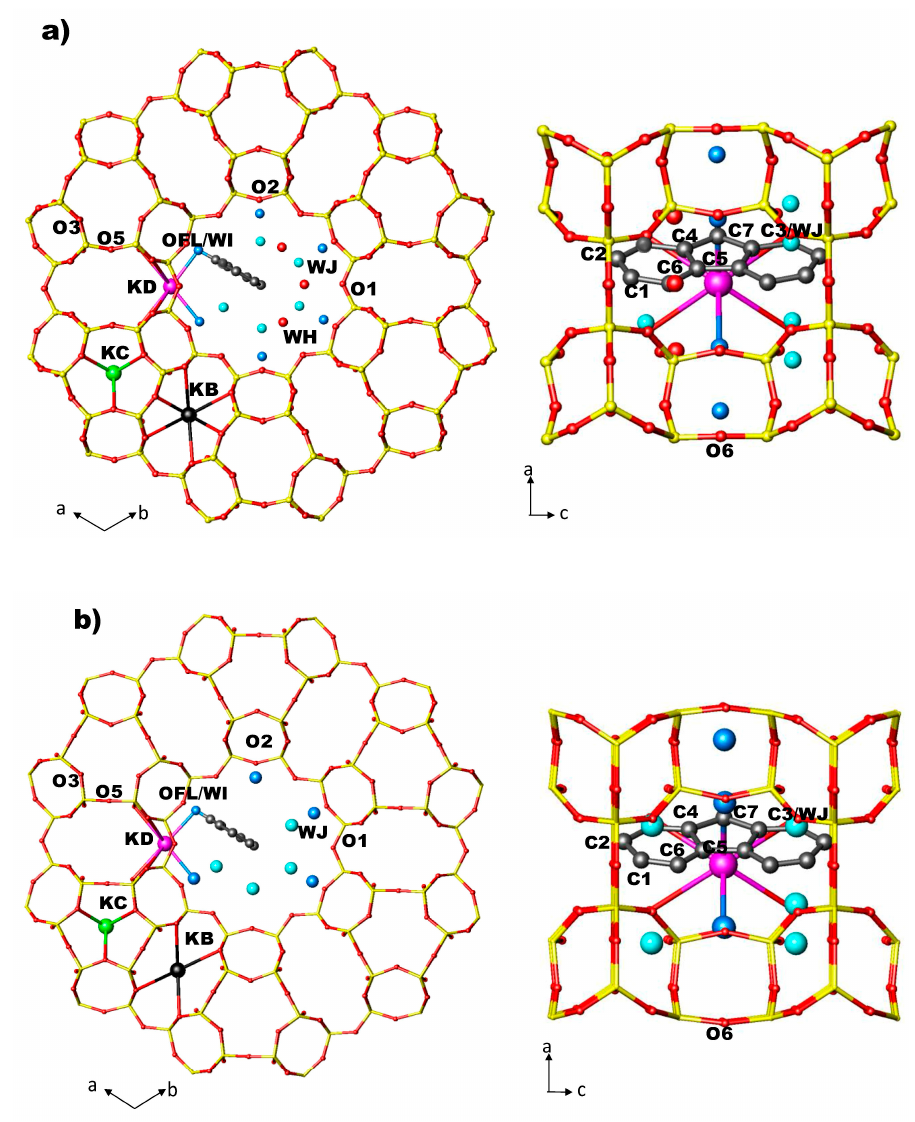
Figure 2. Arrangement of FL and water molecules in the 12 MR channel along [001] and along [010] directions in ZL/0.5FL ( a ) and ZL/1.0FL ( b ) at P amb [56].